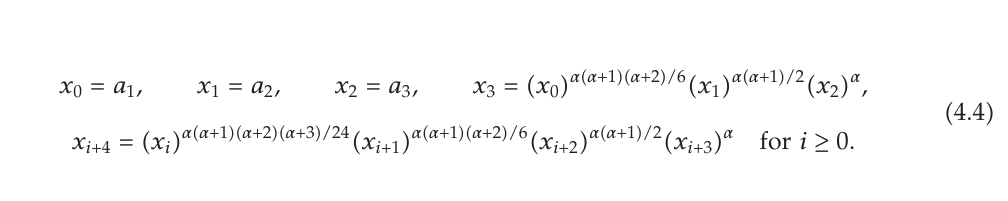
Table 1: The length of h (cid:2) 5 (cid:3)